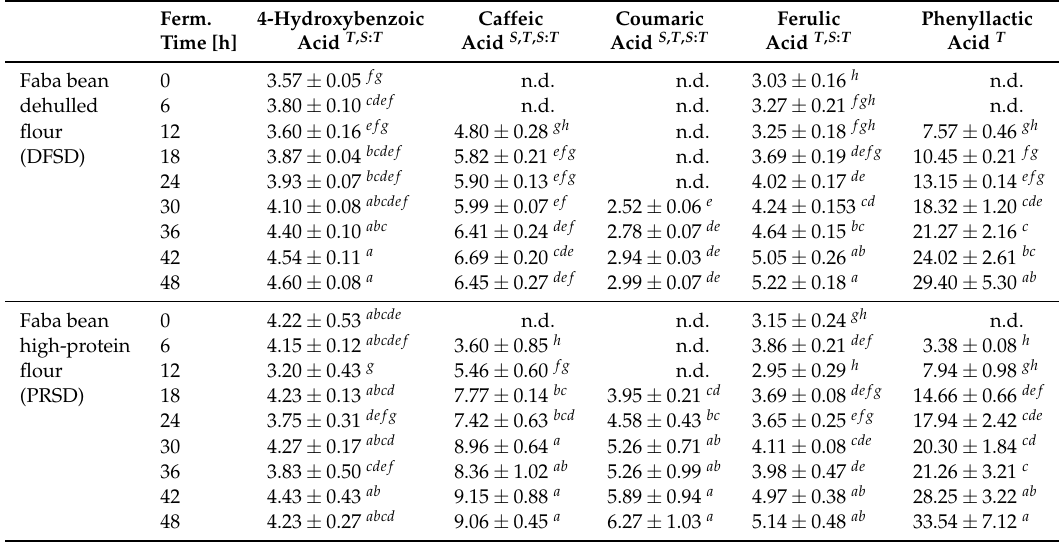
Means ± standard deviation with different lower case letters in the same column are significantly different at p < 0.05. n.d., not detected or levels below 0.02 %DM. S Two-way ANOVA confirmed significant effect ( p < 0.05) of